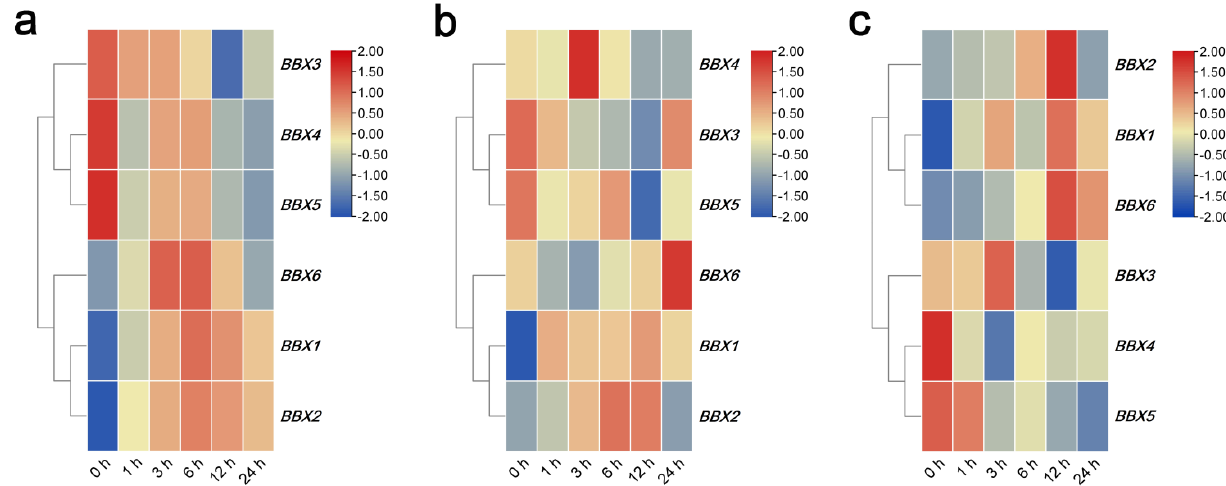
Figure 5. Expression profiles of IgBBX genes in leaf tissue following spraying with ( a ) abscisic acid (ABA), ( b ) methyl jasmonate (MeJA), and ( c ) salicylic acid (SA) treatments. Blue and red indicate down-regulated and up-regulated transcript abundance, respectively, compared to the relevant controls (0 h sample is an untreated sample). Bar on the top right corner represents log 2 transformed values.